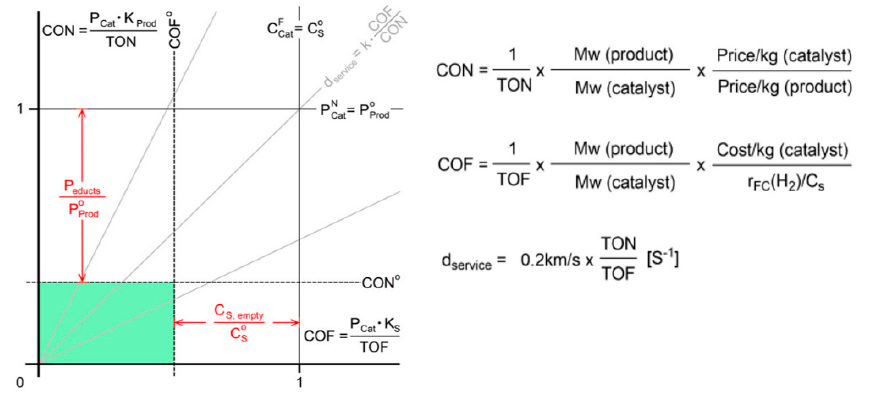
Figure 5. Margins of catalyst price normalized vs. TON (CON) or TOF (COF). According to cost-